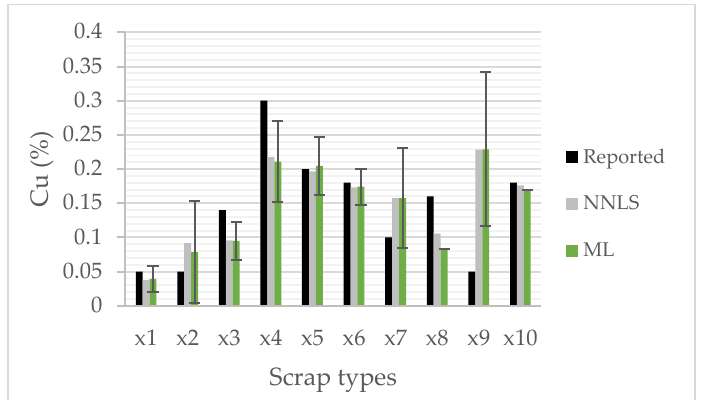
Figure 5. Comparison between the reported Cu concentration and calculated values in scrap (x1–x10).